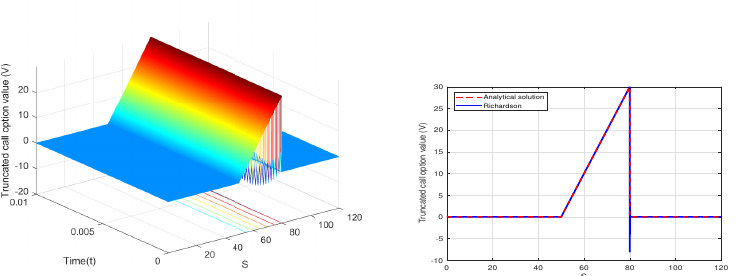
Figure 5. Spurious oscillations in the solution provided by the Richardson method with ∆ S = 0.01, ∆ t = 10 − 4 . Parameter values: r = 0.07, σ = 0.001, T = 0.01, U = 80, K = 50, L = 20, S max = 120.